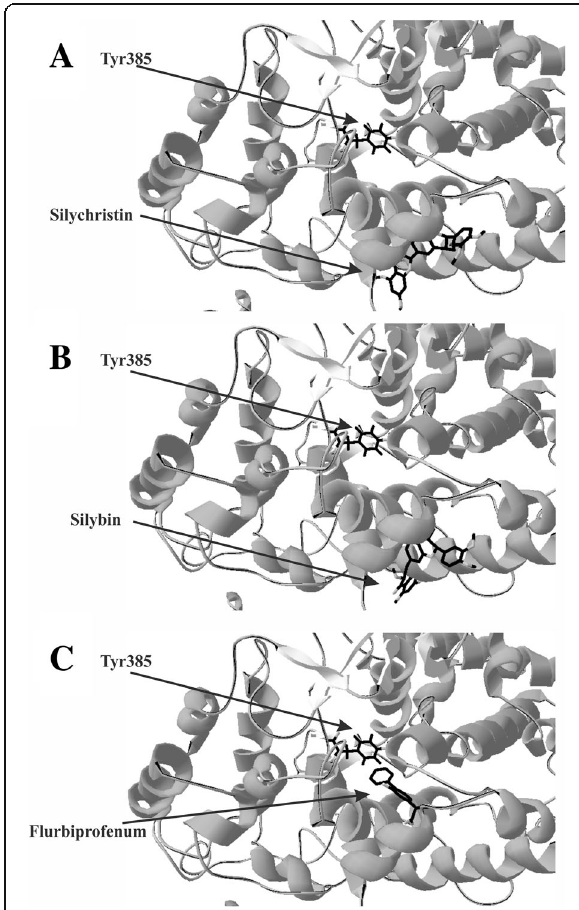
Fig. 5 3D structures of ligand docking to the binding site of cyclooxygenase. The crystal structure of cyclooxygenase (PDB: 3N8Z was taken from the RCSB PDB databank (http://www.rcsb.org/). 3D ligands structures were obtained from the PubChem website (http://pubchem.ncbi.nlm.nih.gov/). Software used for docking was Autodock Vina 1.0 together with Autodock Tools v 1.5.6rc1. Visualization of the docking results (conformation with the